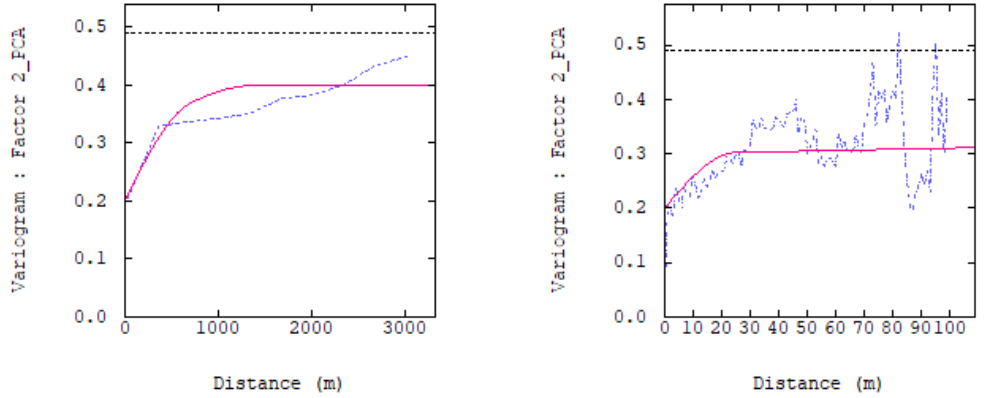
Figure 13. Experimental and fitted anisotropic variogram models for Factor 2. Dashed polylines (blue color) represent experimental variograms; thin dashed lines (black color) represent variance; continuous lines (red color) represent variogram models.